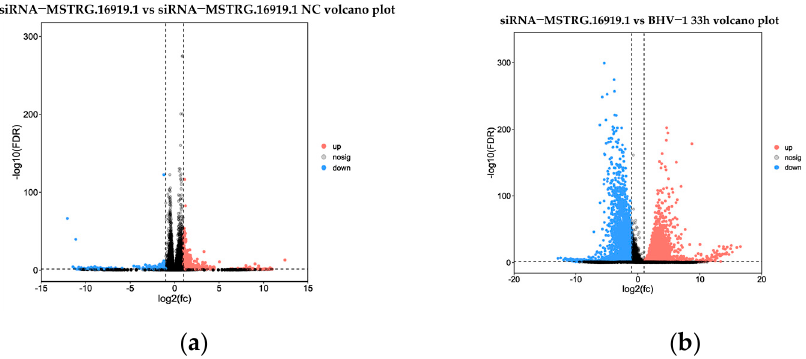
Figure 3. Volcanic map of difference comparisons. ( a ) siRNA − MSTRG.16919.1 and siRNA − MSTRG.16919.1 NC volcano plot; ( b ) siRNA − MSTRG.6919. 1 and BHV − 1 33 h volcano plot. Red dots indicate genes with upregulated transcription level, blue dots indicate genes with downregulated transcription level, and black dots indicate genes whose transcription levels have not changed differently.